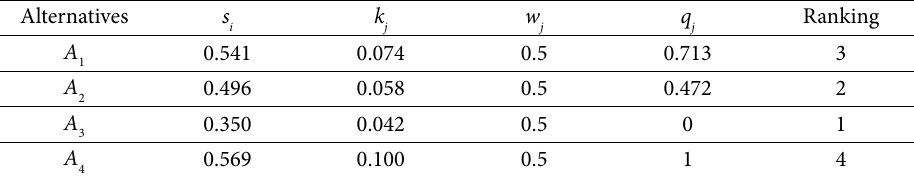
Table 4. Ultimate results and ranking of the